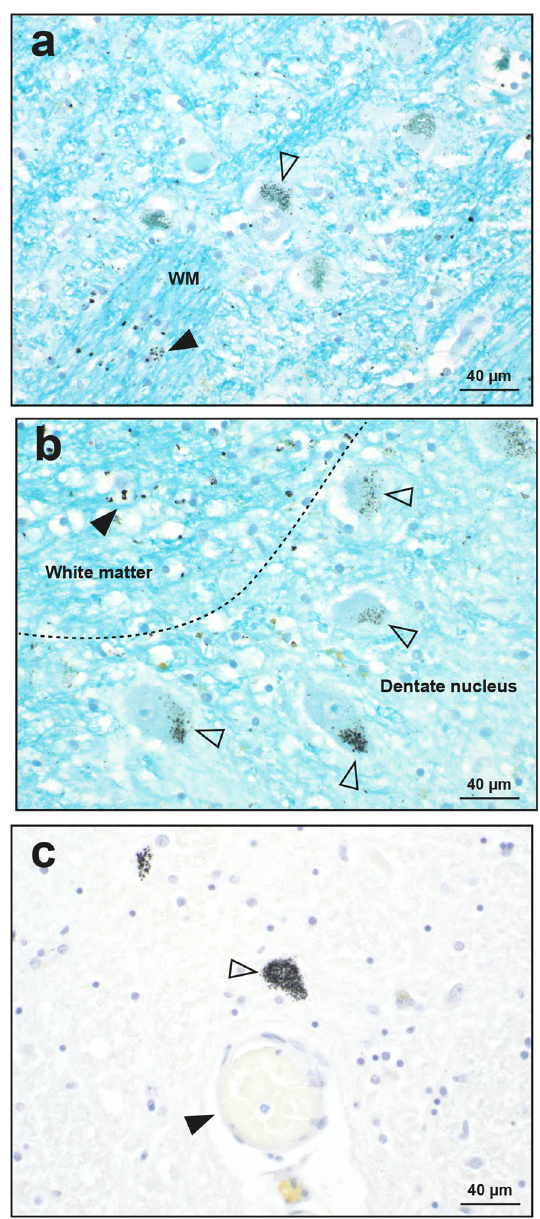
Figure 7. Autometallography of neurons. ( a ) Scattered thalamic neuronal cell bodies (open arrowhead) contain AMG PTE grains. White matter (WM) tracts within the thalamus have numerous AMG PTE-containing glial cells (closed arrowhead). AMG/LFB/CV. MS09. ( b ) Many neurons in the dentate nucleus of the cerebellum contain AMG PTE granules (open arrowhead). The adjacent cerebellar white matter has numerous glia